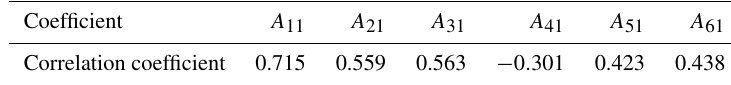
Table 4. Correlation coefficients between A i 1 of GIM-TEC and solar F10.7